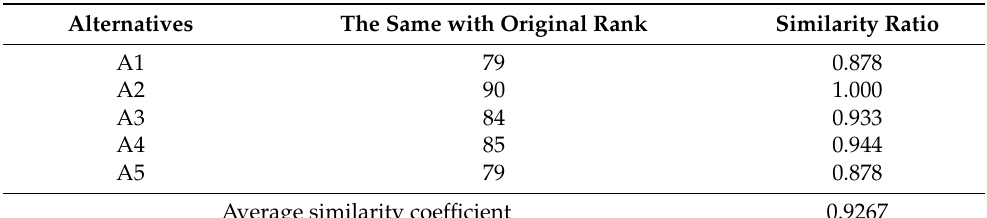
Table 12. The similarity ratio and the average similarity coefficient.